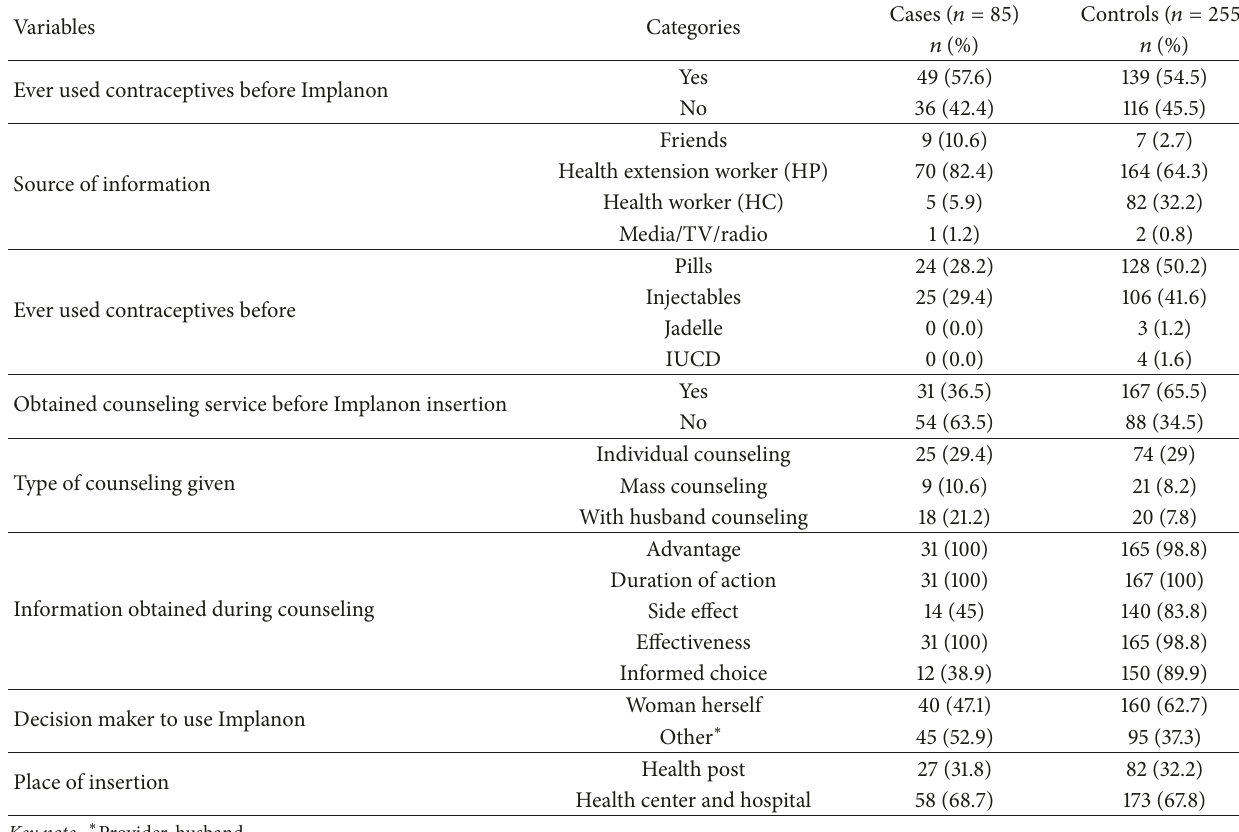
Table 2: Family planning servicerelated characteristicofwomen whoever used Implanonin Diguna Fango District,Wolayita Zone, Southern Ethiopia, March 2017.